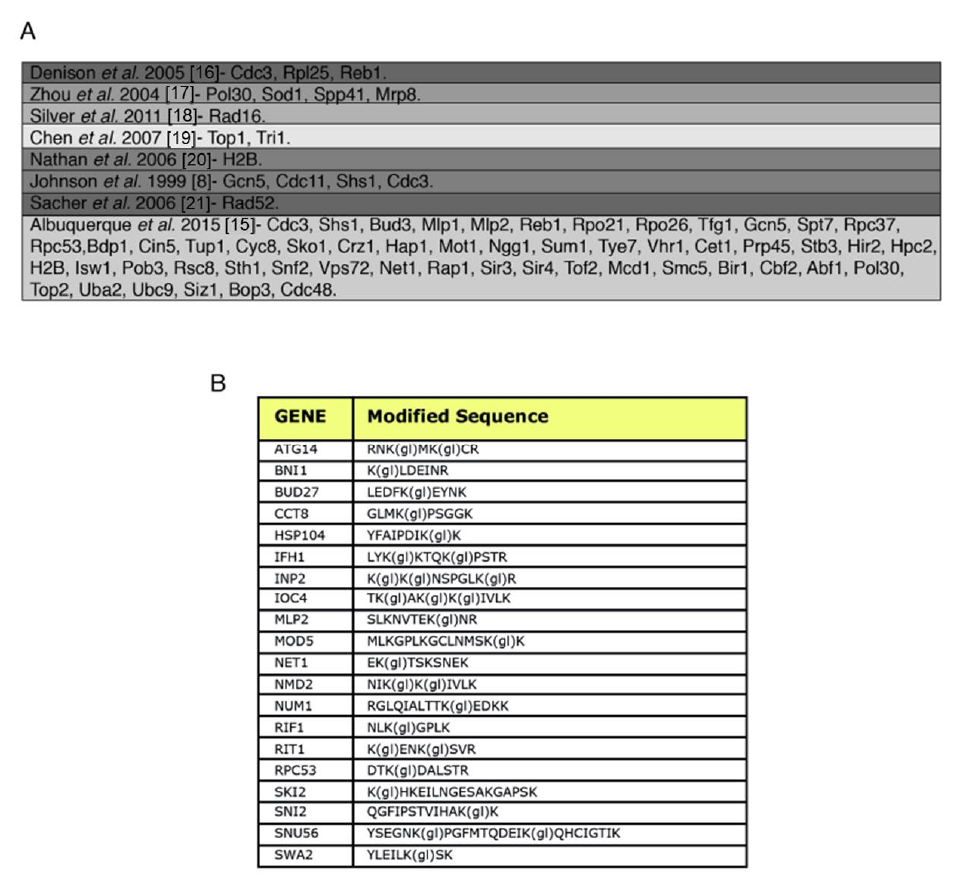
FIGURE 2: SUMO-acceptor lysines detected in our mass spectrometry analysis were compared with SUMO-acceptor lysines already described in previous studies done in S. cerevisiae . (A) Previous studies were based on either MS or site-directed muta- genesis/immunoblotting, or a combination of both. Most of the SUMO-acceptor lysines previously found were also detected in this study. SUMO substrates (total of 257) identified in the yeast proteome of cells grown asynchronously. Previously published SUMO-substrates were obtained [8, 15-21]. (B) To ensure that diglycine-modified lysines detected by mass spectrometry after Smt3 purification are not due to modification by ubiquitin or Nedd8, a centromeric plasmid 8His-SMT3-KallR-REQIGG-pRS415 expressing the Smt3 variant used previously for the Smt3 purification protocol with the difference that the RGG conjugating terminus was replace for the native RIEQGG C-terminus was employed. SUMO-acceptor lysines modified by the 8His-Smt3-KallR-REQIGG keep a side chain of 5 aa after trypsin digestion (EQIGG). Therefore, any diglycine-modified lysines detected by mass spectrometry under these conditions can only be due to either false positive hits, or to ubiquitinated or neddylated contaminants. A large culture of 9 l of the strain expressing the 8His-SMT3-KallR-REQIGG variant was grown in YPD and harvested at O.D. 0.9. Smt3 purification and mass spectrometry analysis was performed as described in Material and Methods. We detected 23 diglycine-modified lysines. None of these corresponded with previously detected diglycine-modified lysines in our Smt3-RGG pulldowns. In addition none of these diglycine-modified lysines are within SUMO consensus sequences. This strongly indicates that sumo-acceptor lysines identified after purification of Smt3-RGG pulldowns represent bona fide SUMOylation